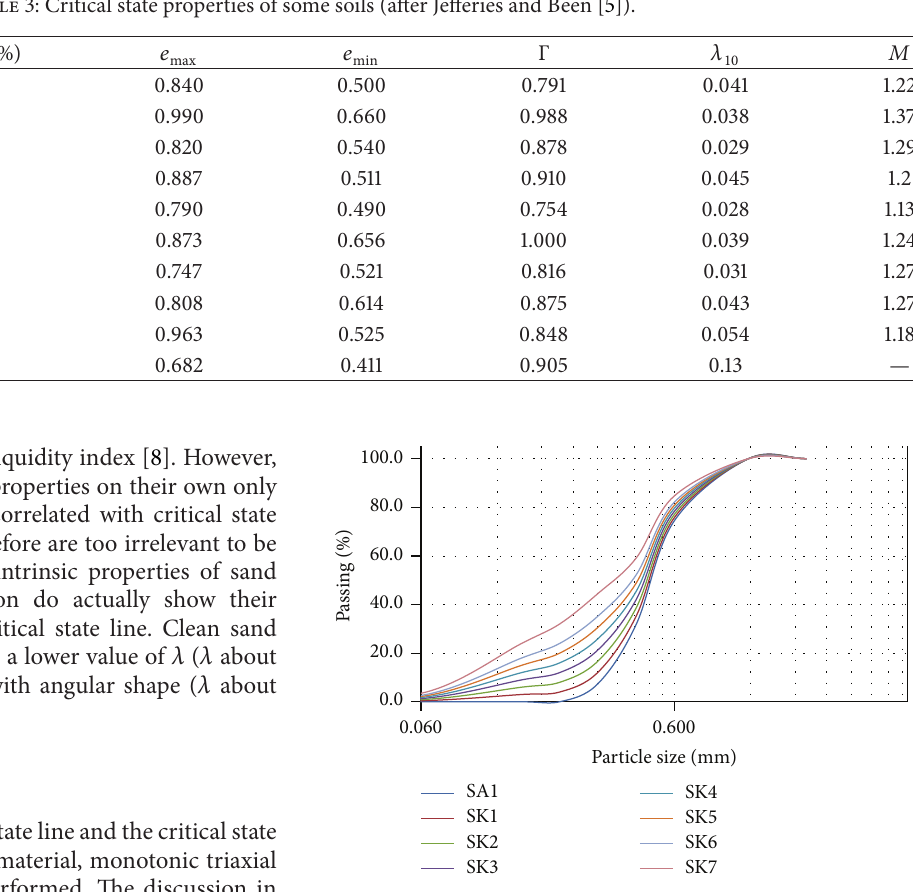
of coefficient of uniformity (Cu) and coefficient of curvature (Cc) in Unified Soil Classification System, all of the sand matrix soils are classified under uniformly graded soils (SP). Particle size distribution is shown in Figure